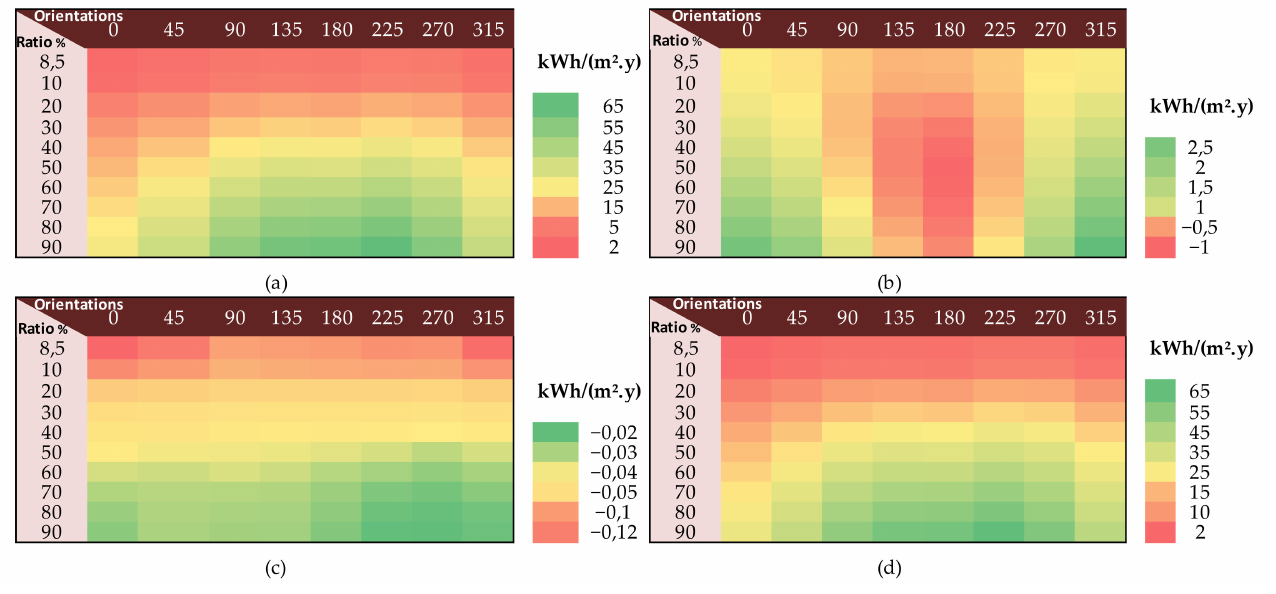
Figure 7. Variation in energy demand resulting from use of EC glazing instead of reference window, as a function of WWR and orientations for ( a ) Cooling. ( b ) Heating. ( c ) Lighting. ( d ) Overall energy consumption per unit area kWh/(m 2